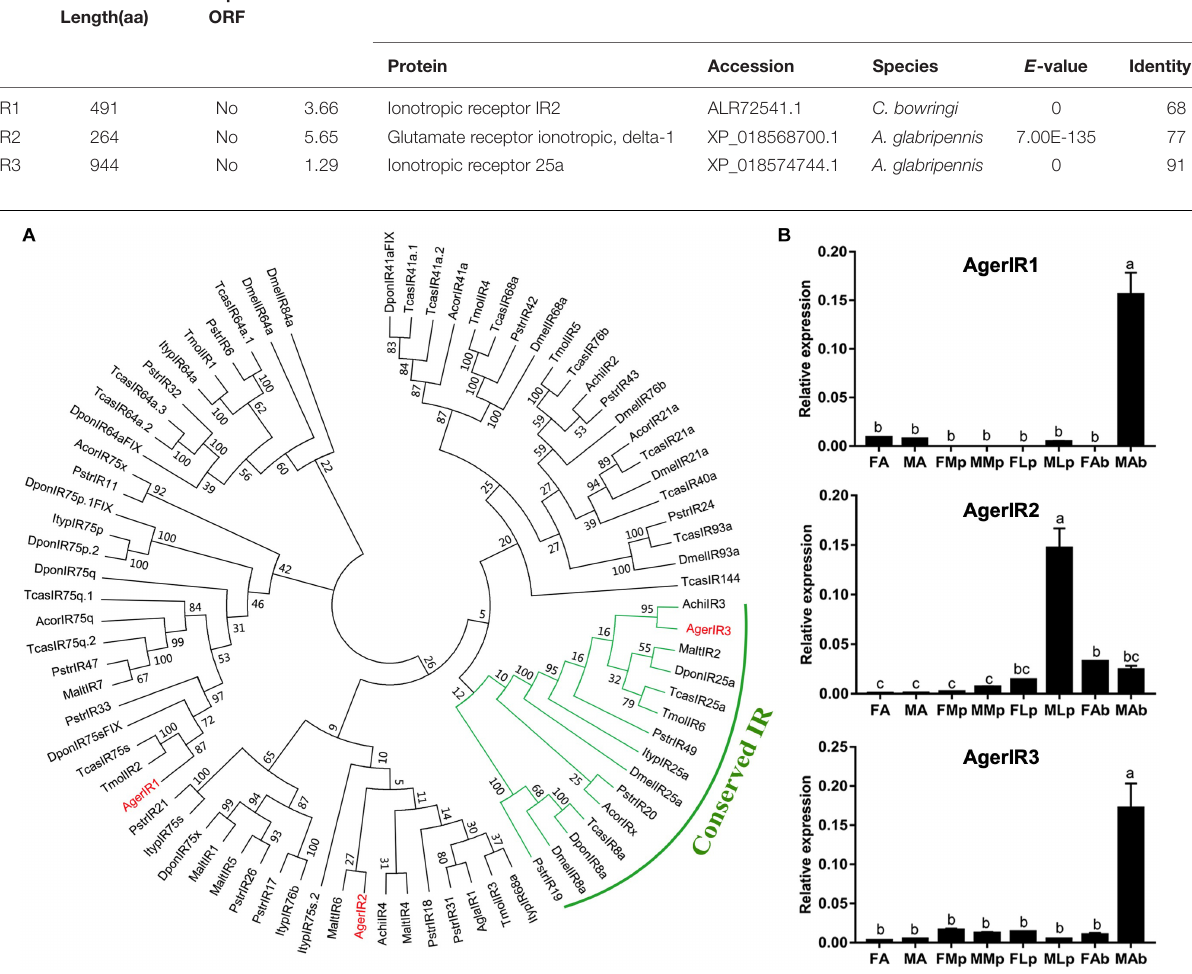
FIGURE 6 | Phylogenetic tree and relative mRNA expression of AgerIRs. (A) A total of 42 ORs (AgerOR1–42) from Apriona germari (Ager) and ORs from Anoplophora chinensis (Achi), Anoplophora glabripennis (Agla), Dendroctonus ponderosae (Dpon), Drosophila melanogaster (Dmel), Phyllotreta striolata (Pstr), Anomala corpulenta (Acor), Monochamus alternates (Malt), Megacyllene caryae (Mcar), Tenebrio molitor (Tmol), and Tribolium castaneum (Tcas) were used to construct the phylogenetic tree. (B) Relative mRNA expression of AgerIRs. The relative mRNA levels were normalized to those of the actin gene and analyzed using the Q-gene method. All values are shown as mean ± SEM normalized. The data were analyzed by least significant difference test after one-way analysis of variance. Different letters (a–c) indicate significant differences between means ( P < 0.05). FA, female antennae; MA, male antennae; FMp, female maxillary palps; MMp, male maxillary palps; FLp, female labial palps; MLp, male labial palps; FAb, female abdominal end; MAb, male abdominal